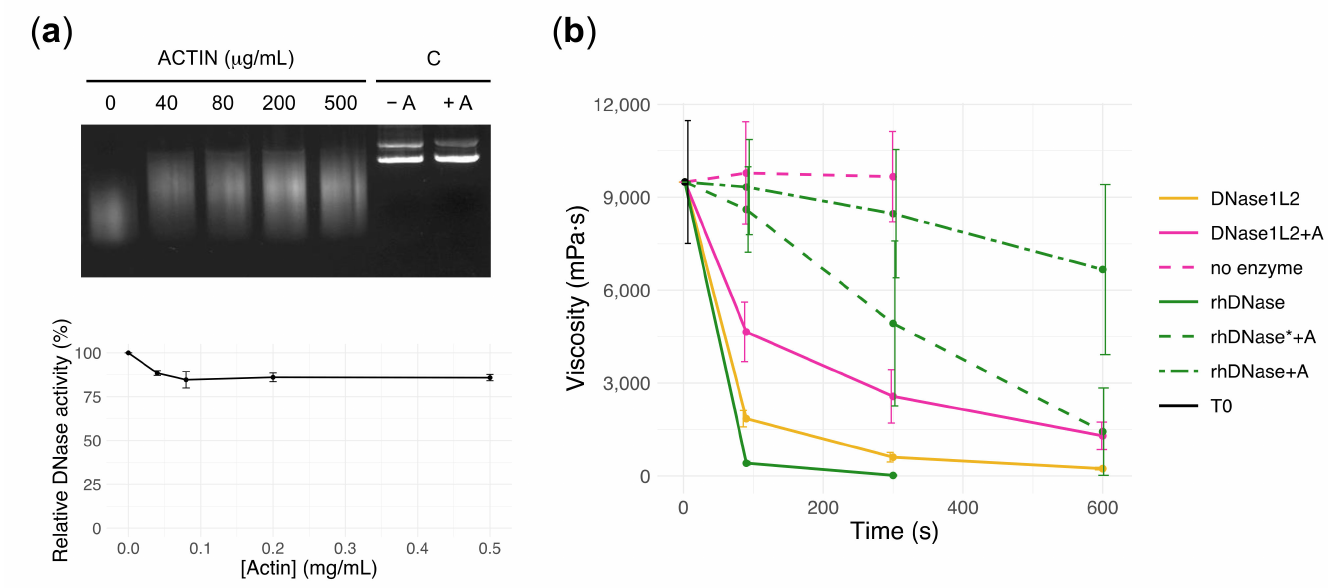
Figure 3. DNase1L2 reduces viscosity of cystic fibrosis (CF) artificial mucus with marked resistance to actin inhibition. ( a ) Agarose gel electrophoresis (upper panel) and densitometric analysis (bottom panel) showing the effect of actin on plasmid DNA digestion by DNase1L2. C: control, purified plasmid DNA without enzyme in the absence (-A) and in the presence of actin (+A). Data are means ± SD of two independent experiments. ( b ) Viscosity measurements showing the activity of DNase1L2 and rhDNase in CF artificial mucus (CF-AM). Activity of DNase1L2 (5 units: 20 ng/ µ L, pink solid and dashed line) and rhDNase (5 units: 2 ng/ µ L, green solid and dashed line, or 50 U: 20 ng/ µ L, green dashed-dot line) was tested in the presence (0.2 mg/mL) or absence of actin (A). T0 is CF-AM at the beginning of measurement. Data are means ± SD of at least two independent experiments. Viscosity values (mPa · s; mean ± SD) are reported in Table